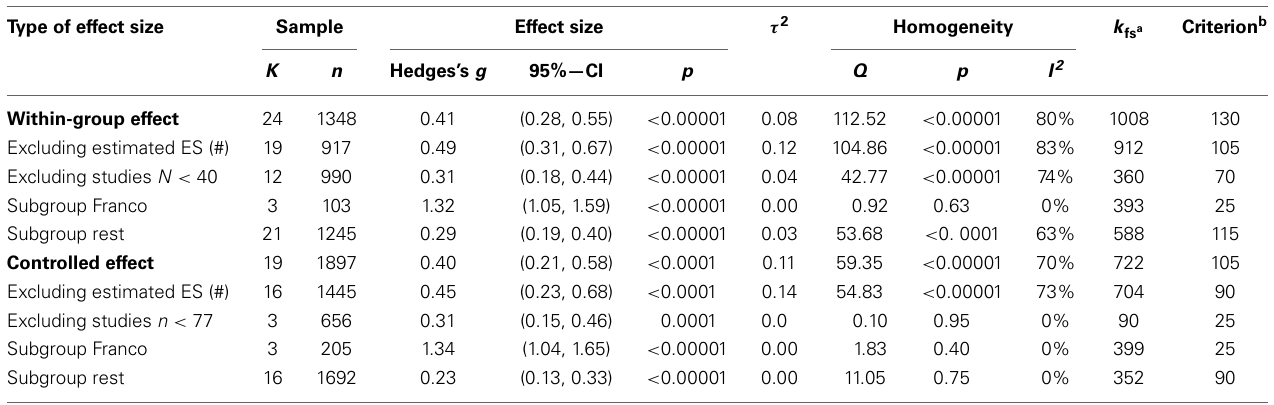
Table 3 | Overall within-group and controlled effect sizes and respective subgroup effect sizes, including effect size statistics.